Question: Briefly state, in one sentence, what is plotted here.
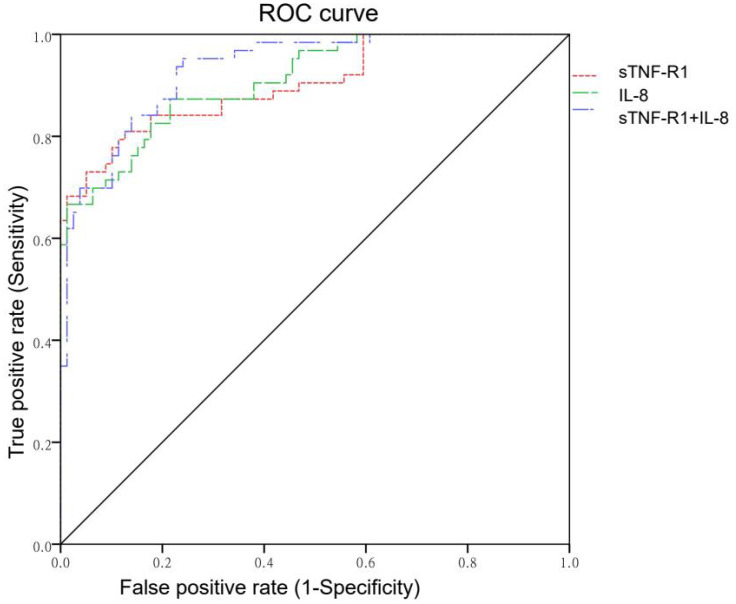
Answer: ROC curve comparing the diagnostic performance of sTNF-R1, IL-8, and the combination sTNF-R1 plus IL-8, showing sensitivity versus 1-specificity, with adiagonal reference line for random prediction.